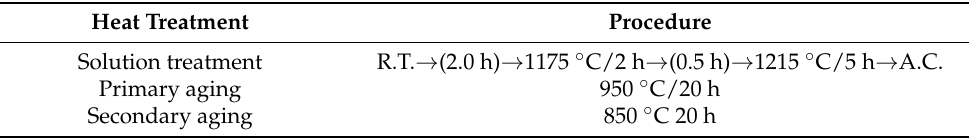
Table 1. Heat treatment condition of high-entropy superalloy (HESA) in this